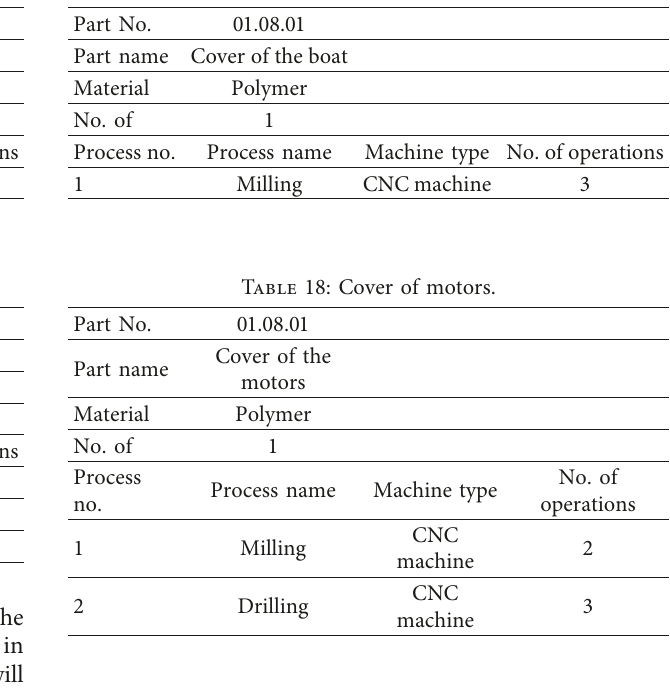
Table 17: Cover of the boat.